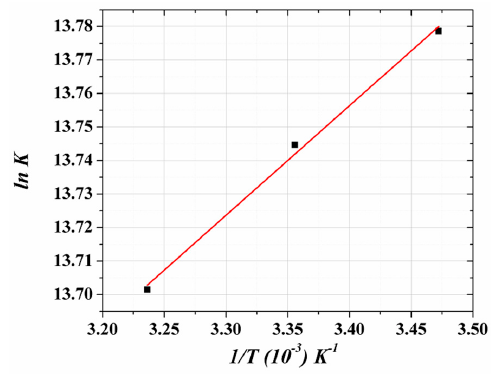
Figure 6. An exothermic Van’t Hoff plot for compound 3 -BSA binding.